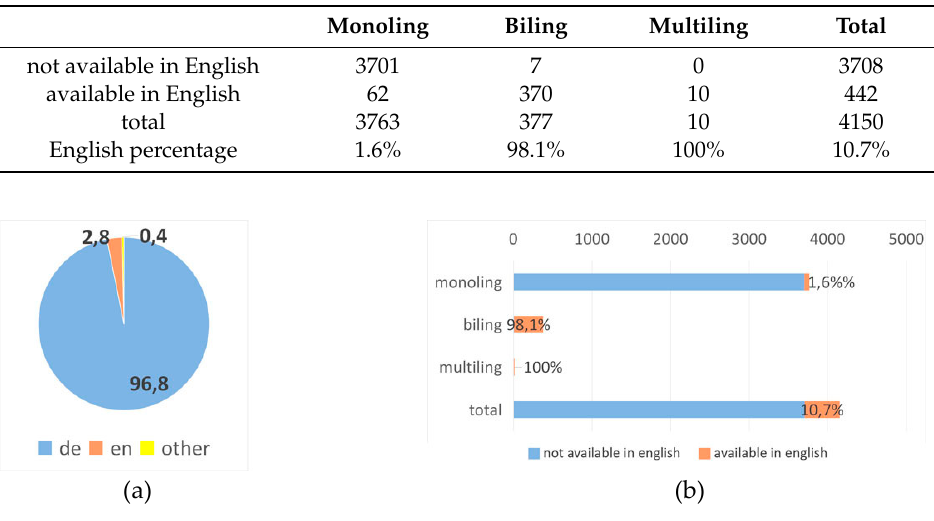
Figure A11. Visualization of the results for domain de. ( a ) Primary languages pie chart and ( b ) English language availability bar chart.